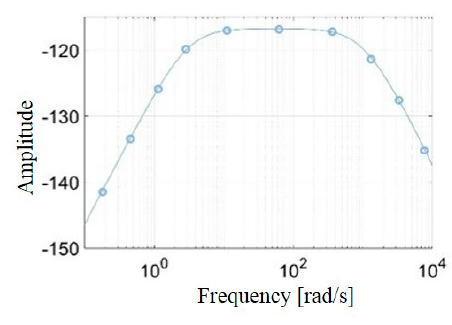
Figure 8. Transfer function shape of the resonant circuit using the NI coil.